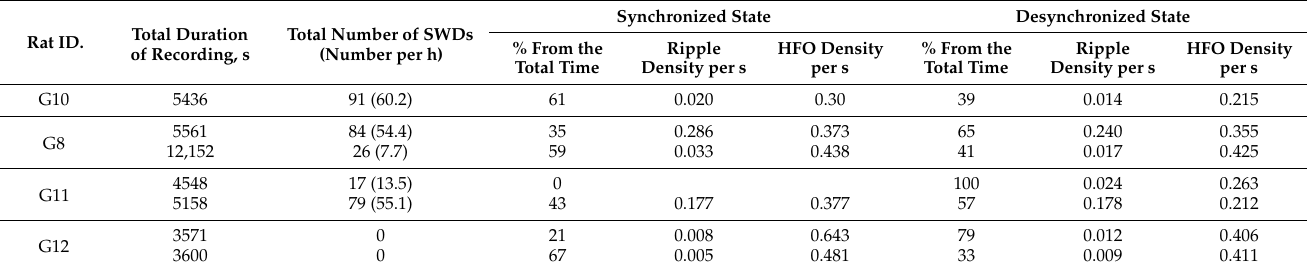
Table A1. Individual data obtained in WAG/Rij rats: the number of SWDs, synchronized and desynchronized EEG states, density of ripples and HFO.